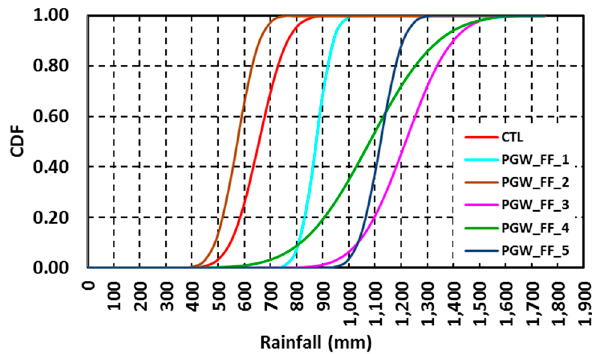
Figure 10. The cumulative distribution curves of average total rainfall from nineteen ensemble members simulated by PGW_FF experiments and the CTL run.